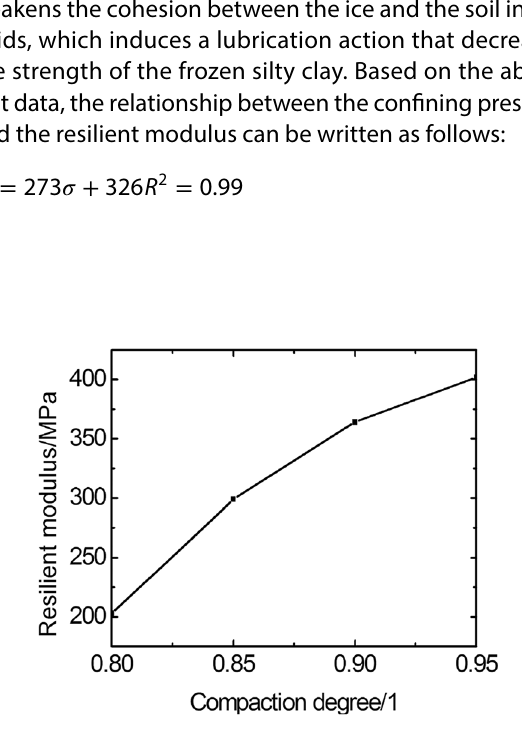
Fig. 10 Influence of the compaction degree on the resilient modu-